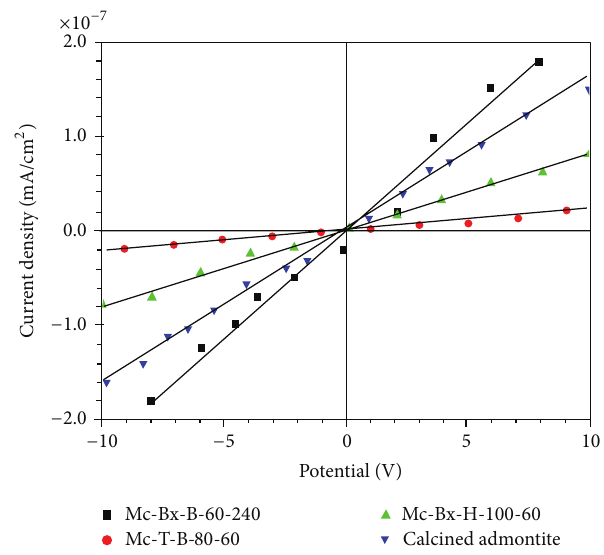
Figure 10: The current voltage characteristics of different magne- sium borate